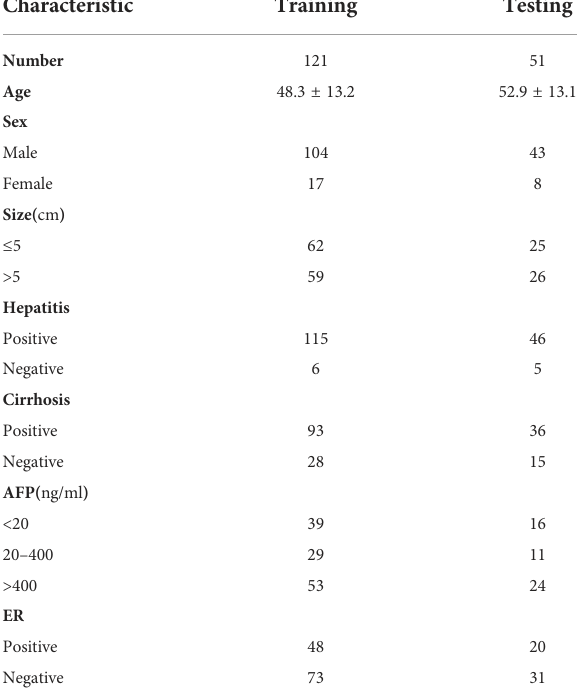
TABLE 1 The clinicopathological features in the training and testing tests.